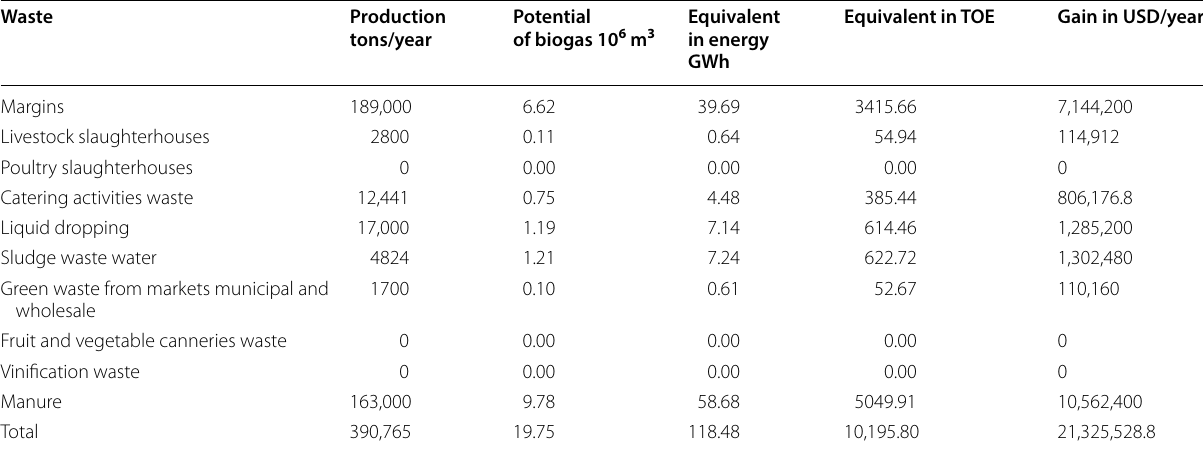
Table 7 Potential of biogas in the Southeast of Tunisia